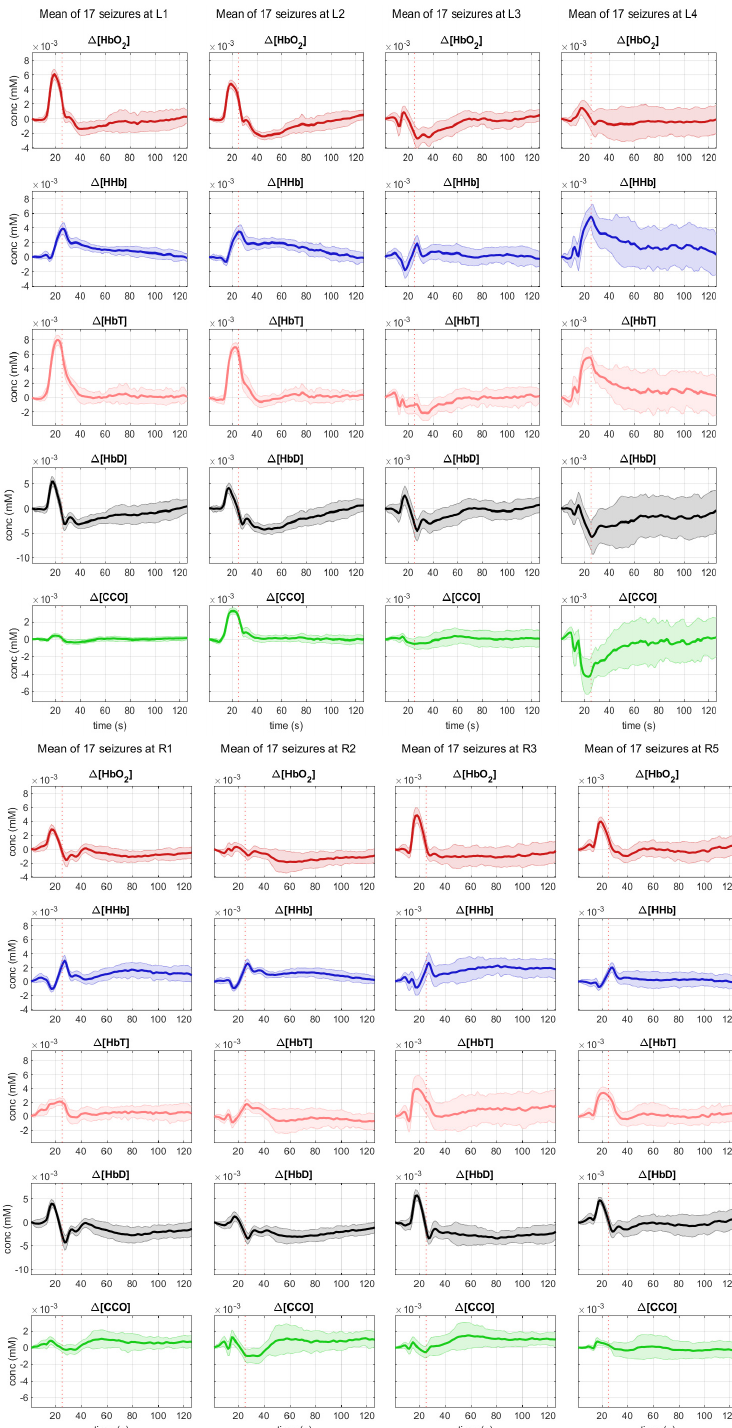
Figure 2. Mean changes during 17 seizures in bNIRS parameters HbO 2 (red), HHb (blue), HbT (pink), Hbdiff (black) and [oxCCO] (green) from 20 s pior to seizure generalization (dotted line) to 100 s after seizure generalization.